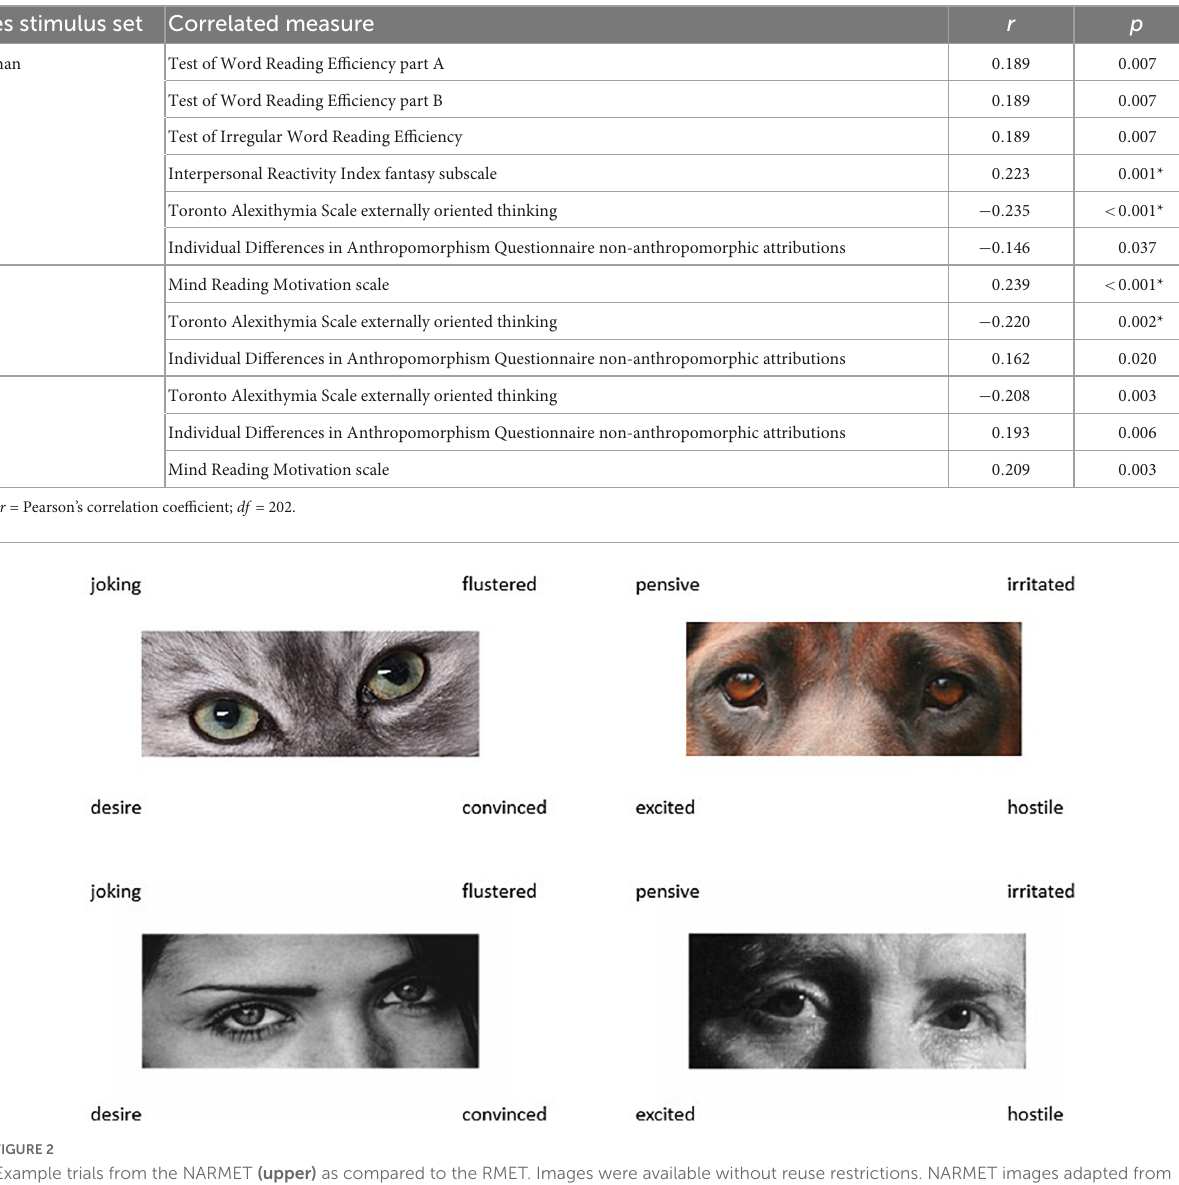
TABLE 1 Correlations between eyes stimuli set scores and other measures.